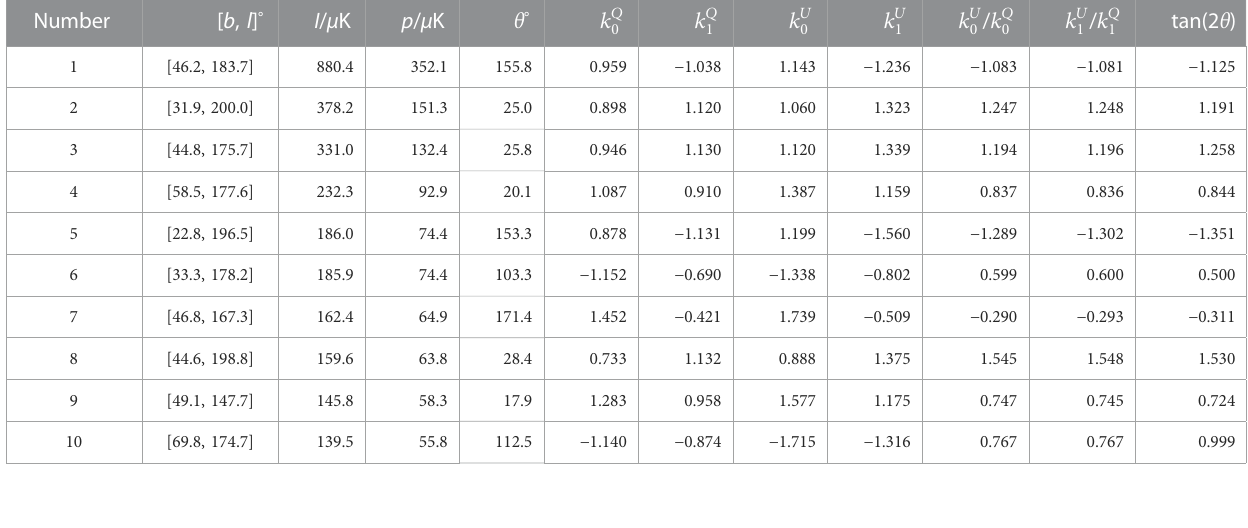
TABLE 4 Location,temperature, polarization and fi tting parameter result with random polarization direction of actual 10 brightest point sources in the region we study (the region shape is the same with Figure 3) when r = 0.023.